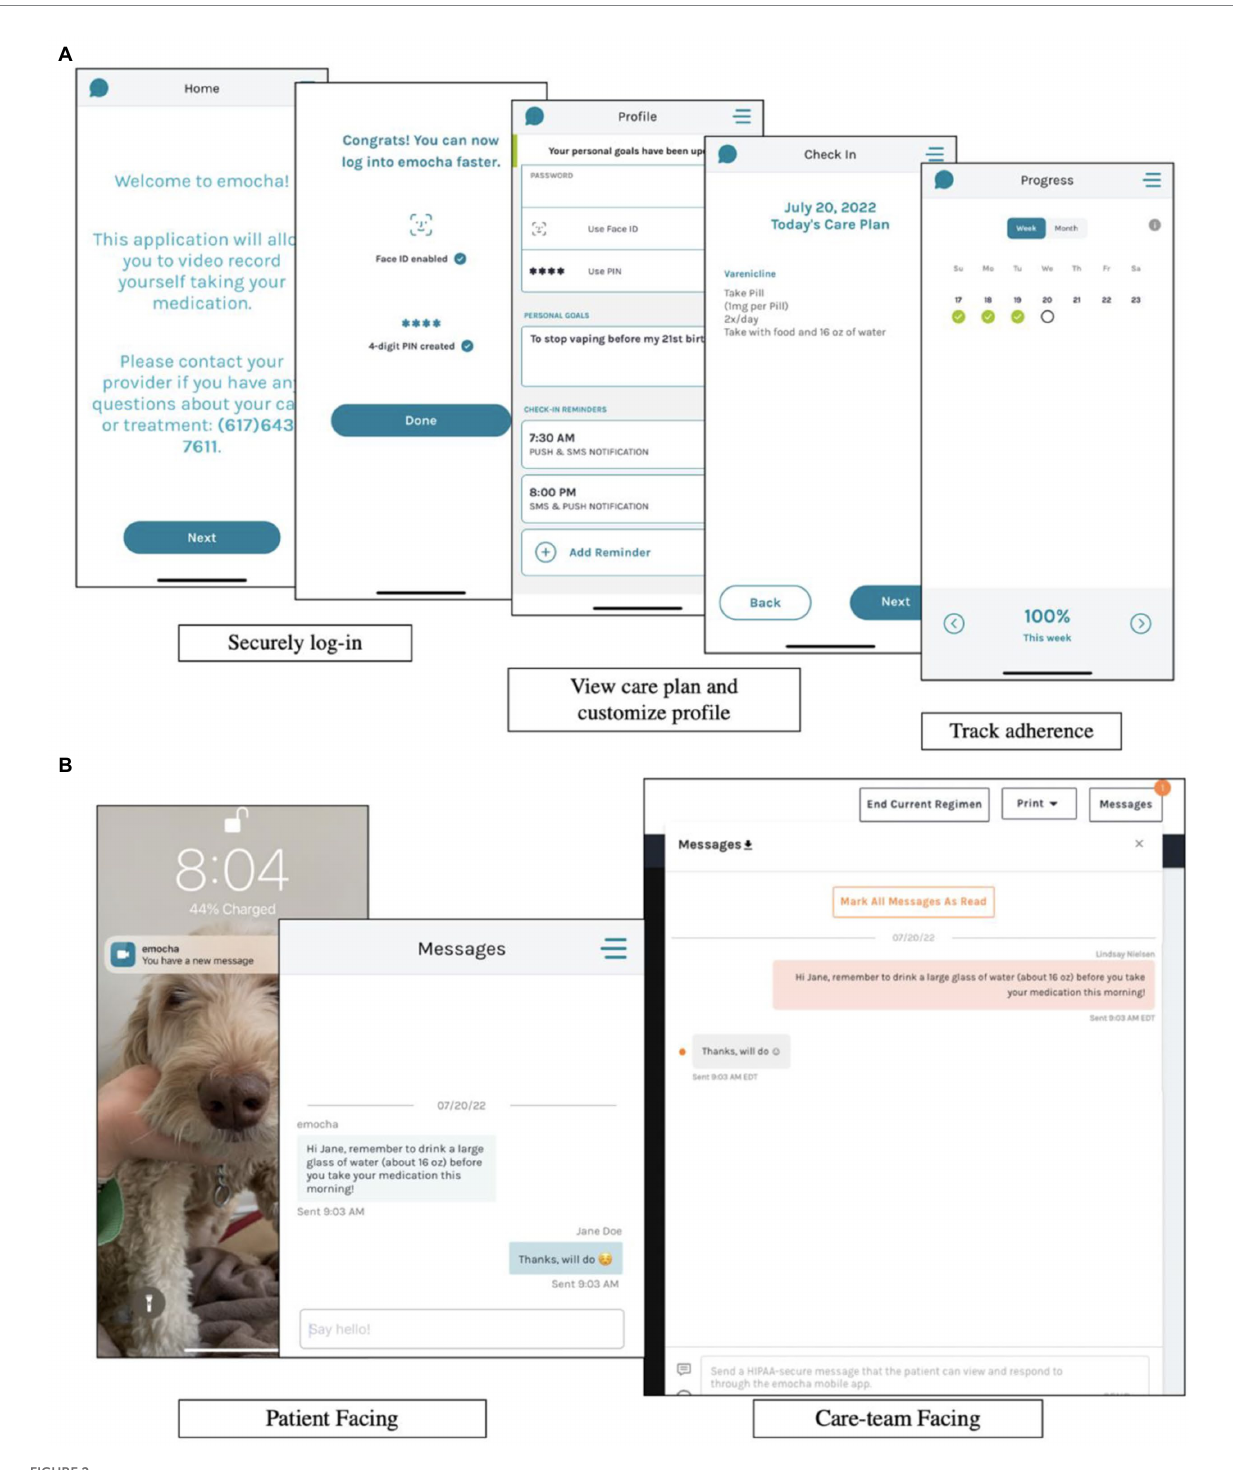
The primary outcome is cotinine-verified, continuous nicotine